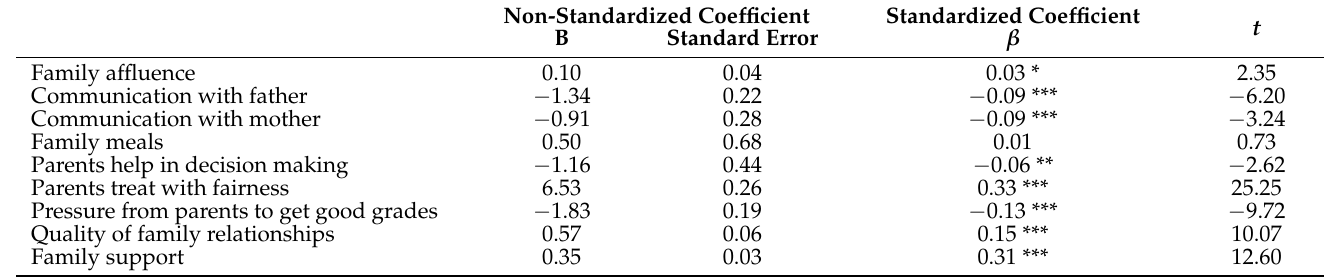
Table 4. Linear regression between adolescents’ quality of life and family environment